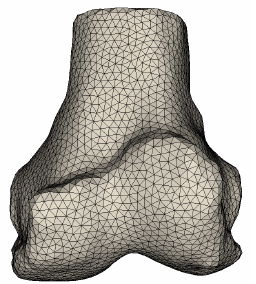
Figure 1. A mesh of the distal